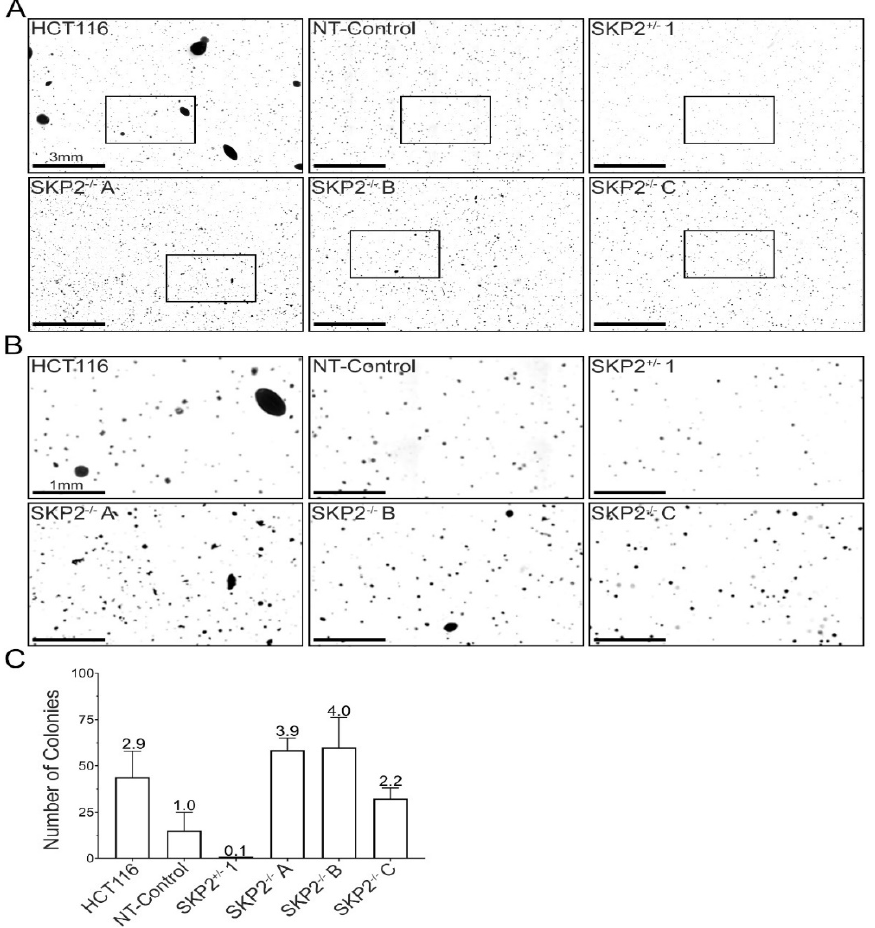
Figure 7. Reduced SKP2 Expression Alters Anchorage-Independent Growth. ( A ) Low-resolution montages presenting colony formation in soft agar. Bounding boxes identify the corresponding magnified regions presented in ( B ). ( C ) Bar graph presenting the mean number of colonies ( ≥ 100 µ m in diameter), with the mean fold increases relative to NT-Control presented above each column. (N = 1, n =